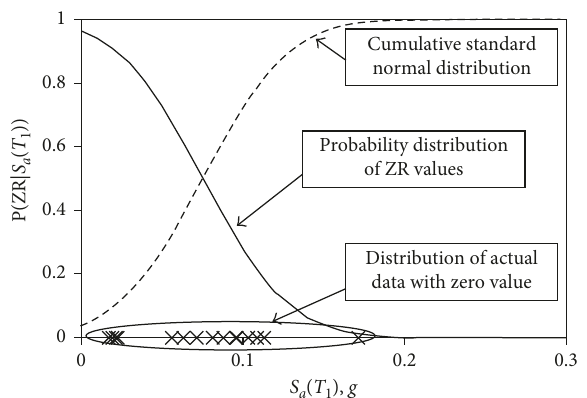
Figure 8: Fractional reduction in dispersion versus T (b) EDP � DI base , (c) EDP � E D , and (d) EDP � DI neck .